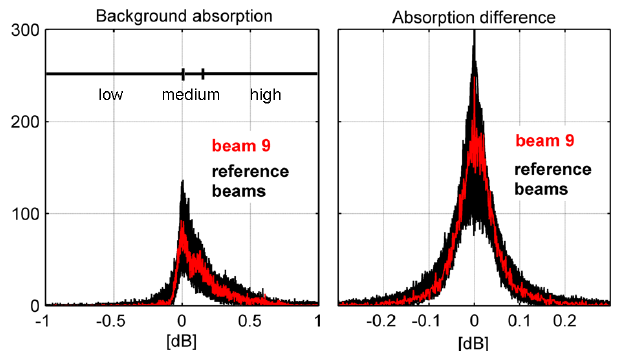
Fig. 7. Left panel: Histogram of background absorption (relative to quiet-day curve) during all selected heating experiments. Lines show the classification into low, medium and high background ab- sorption cases, with one third of the points in each category. Right panel: Histograms of calculated absorption differences for IRIS beam 9 and the reference beams (all beams except no. 9) for these experiments.